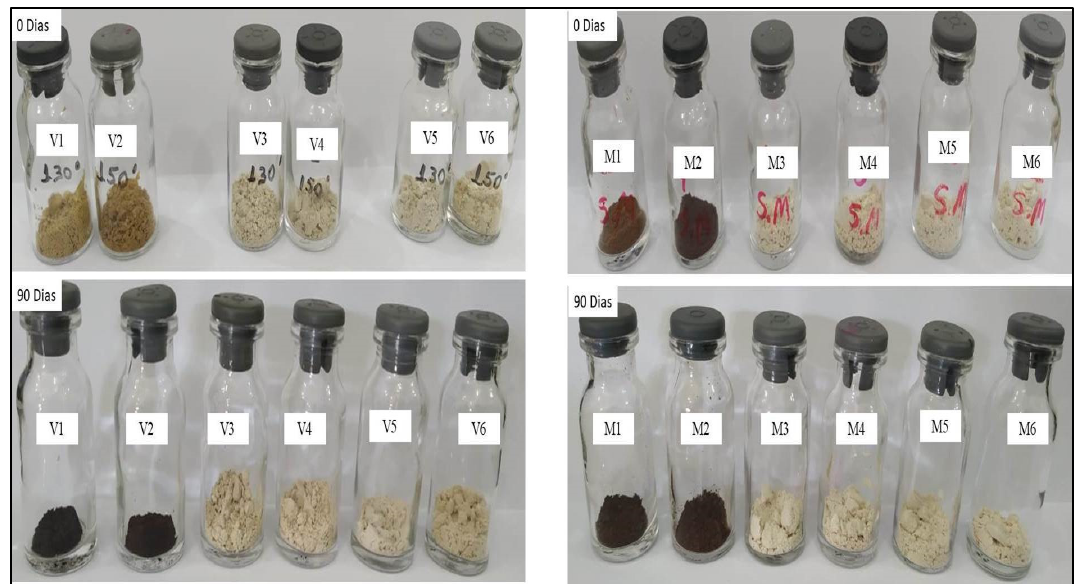
Figure 3. Appearances of powders in the very beginning (top) and after 90 days of storage (bottom). V1, V3 and V5: Unripe seed extracts with 0%, 15% and 30% maltodextrin, respectively, dried at 130 °C; V2, V4 and V6: Unripe seed extracts with 0%, 15% and 30% maltodextrin, respectively, dried at 150 °C; M1, M3 and M5: Ripe seed extracts with 0%, 15% and 30% maltodextrin, respectively, dried at 130 °C; M2, M4 and M6: Ripe seed extracts with 0%, 15% and 30% maltodextrin, respectively, dried at 150 °C.